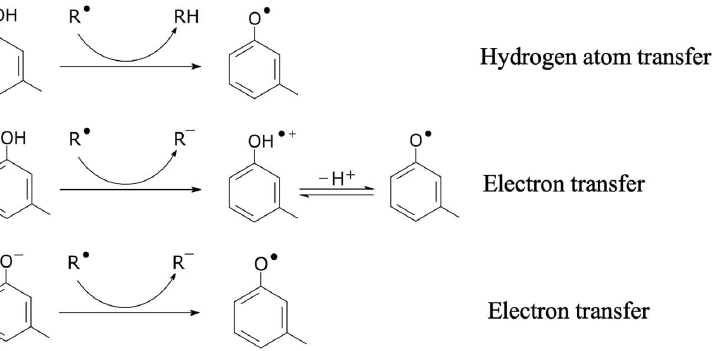
Figure 2. Scheme of reactions between the phenolic compounds and free radicals (modified from [8]).